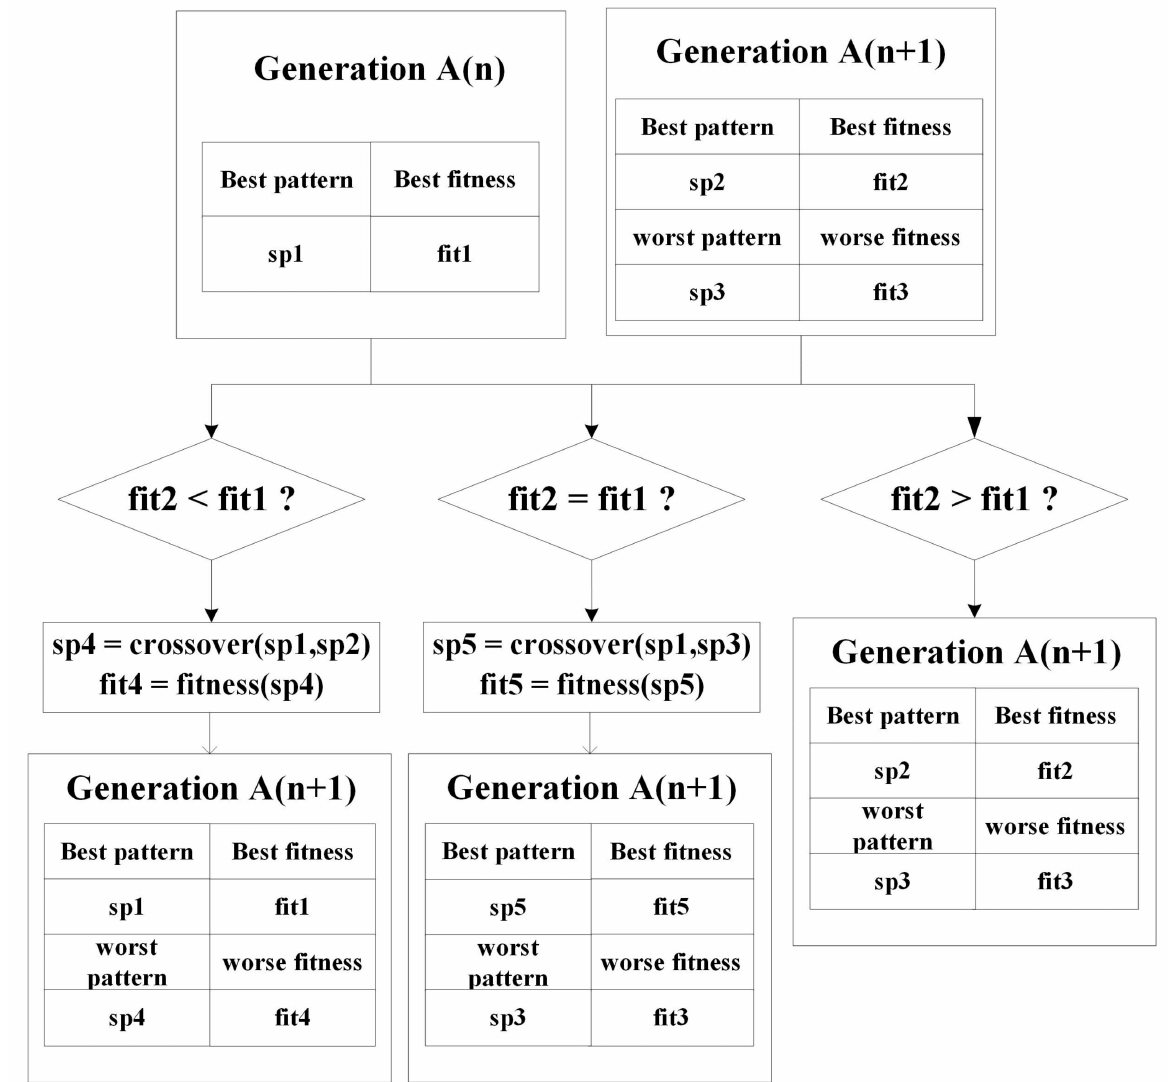
Figure 6. Replacement mode in the elite strategy applied to a current and future generation ( A ( n ) and A ( n + 1) respectively) for the three cases of relative fitness